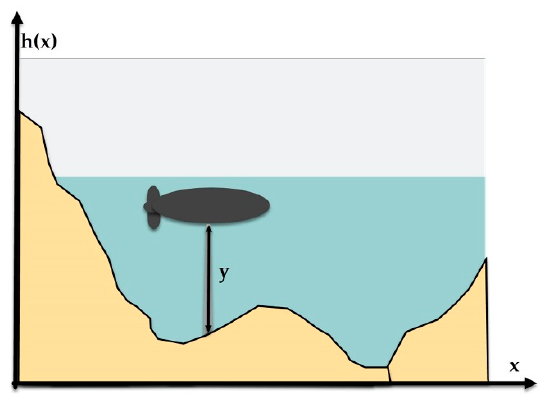
Figure 10. Terrain-Referenced Navigation.